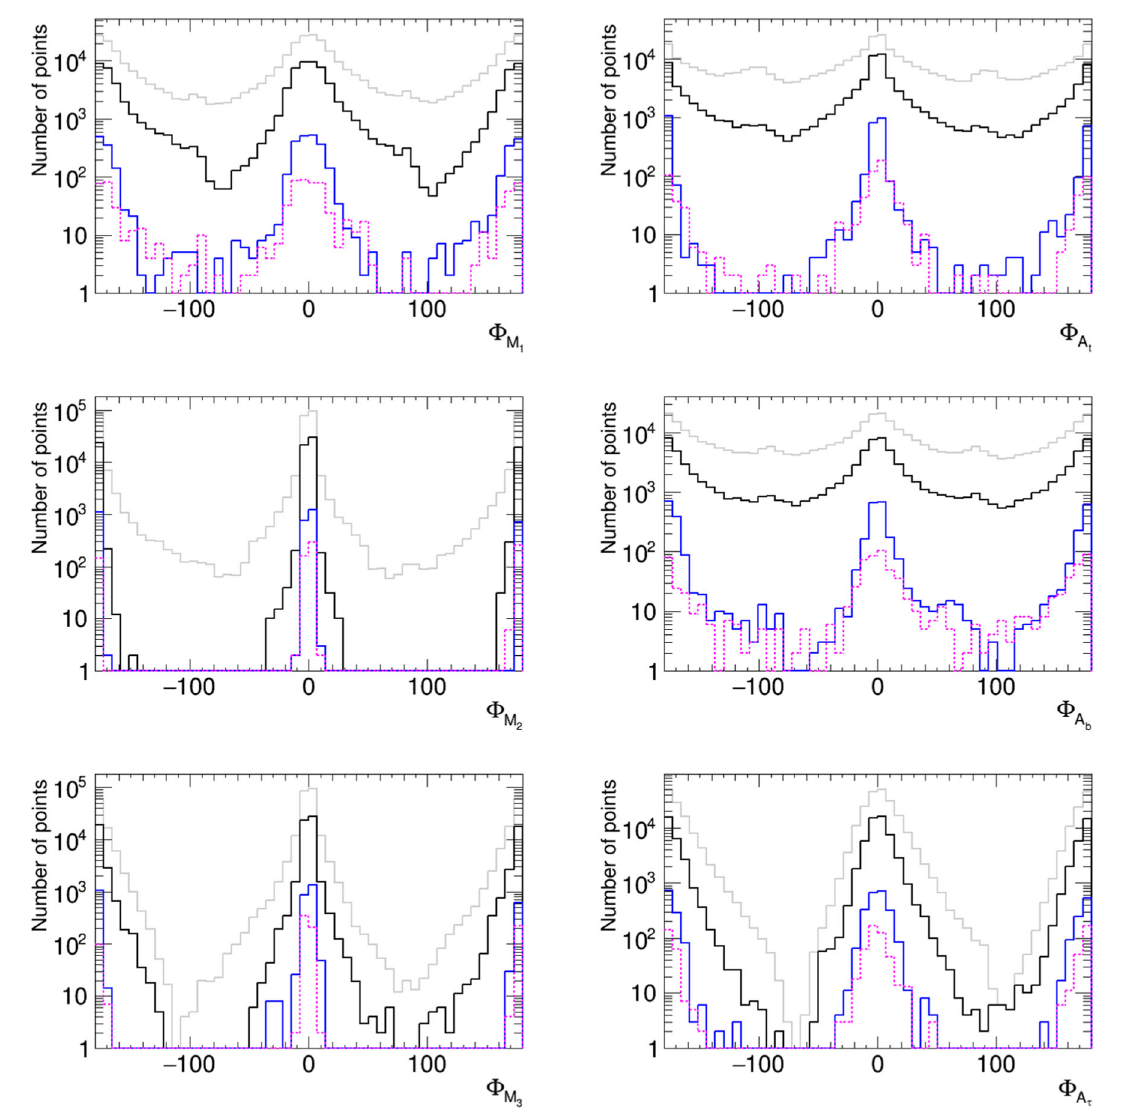
Fig. 4 DistributionsofCP-violatingphases,showingtheeffectsoftak- ing into account the LHC constraints on sparticle masses and imposing the EDM constraints. Left column, from top to bottom: the gaugino ,φ ,φ phases φ M M 2 M 3 ; right column, from top to bottom: the trilin- 1 ,φ ,φ ear phases φ A A b A τ . Grey histograms: all points passing the LHC t